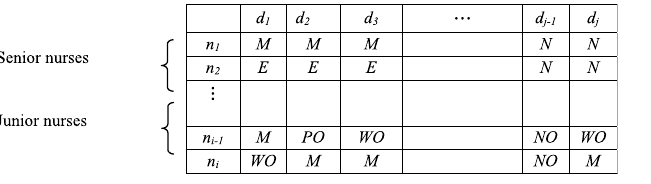
Figure 2. The solution encoding